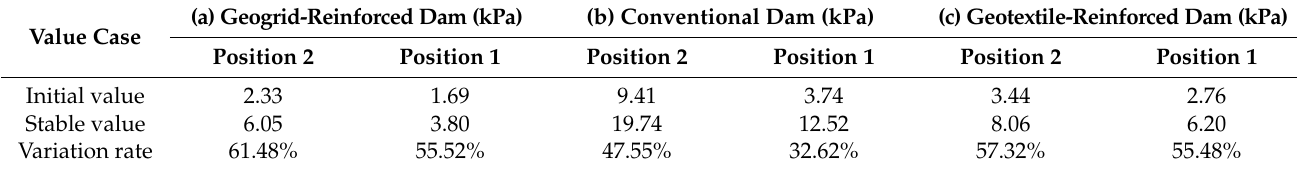
Table 5. Variation of pore pressure in the dam